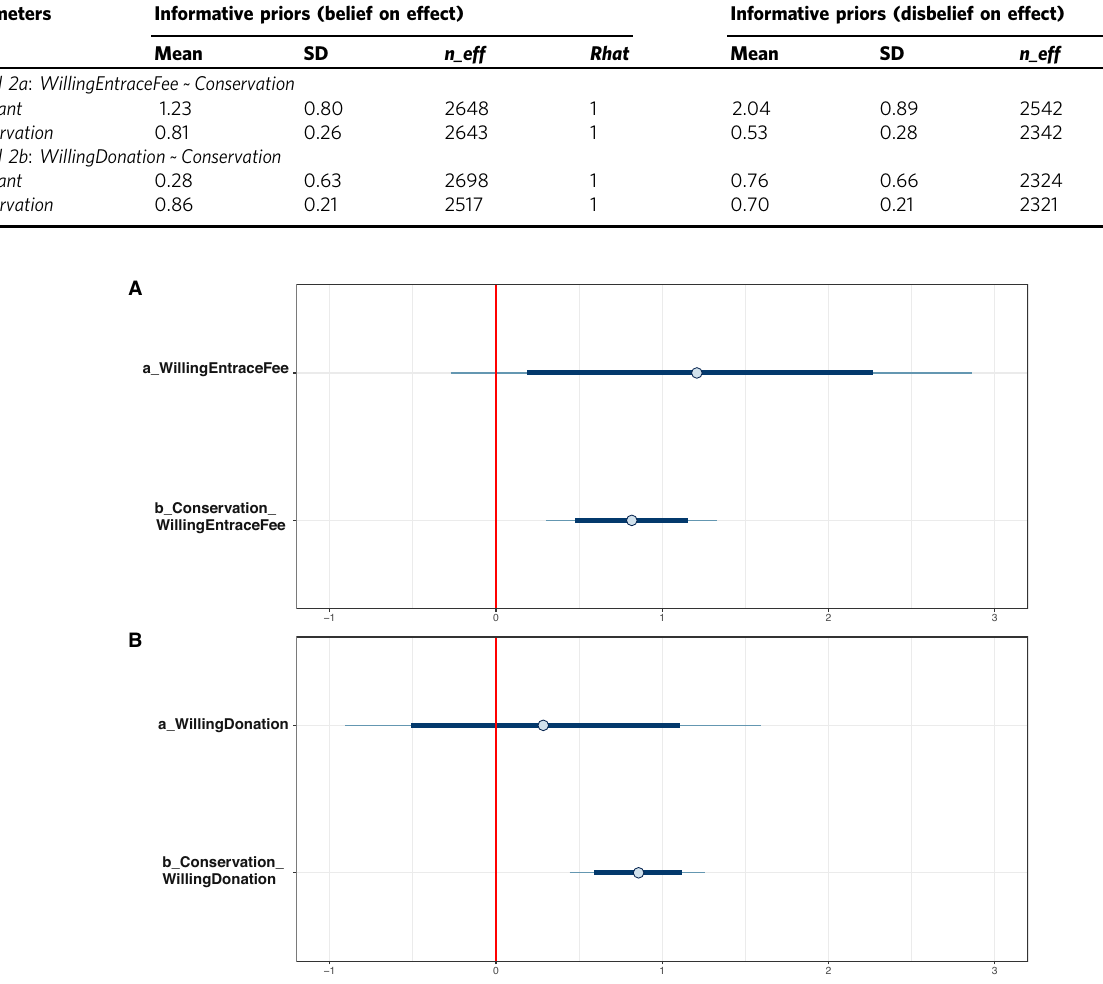
Fig. 8 Interval plots of posterior distributions. A Model 2a and B Model 2b. The red straight line at the origin signi fi es the boundary between the negative and positive areas. The thick blue lines represent the probability mass within the 89% highest posterior density intervals, while the thin blue lines represent the probability mass located outside the highest credible region.